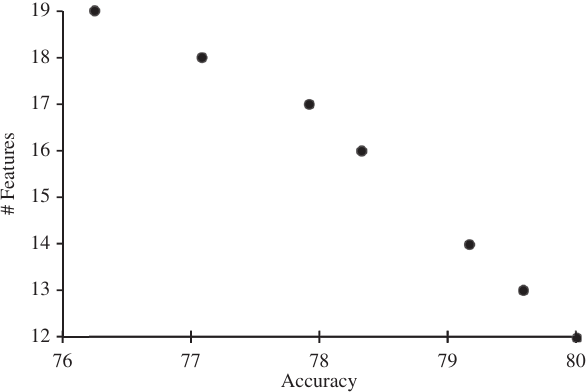
Figure 3. Non-dominated Solutions in Case of the German Data Set.